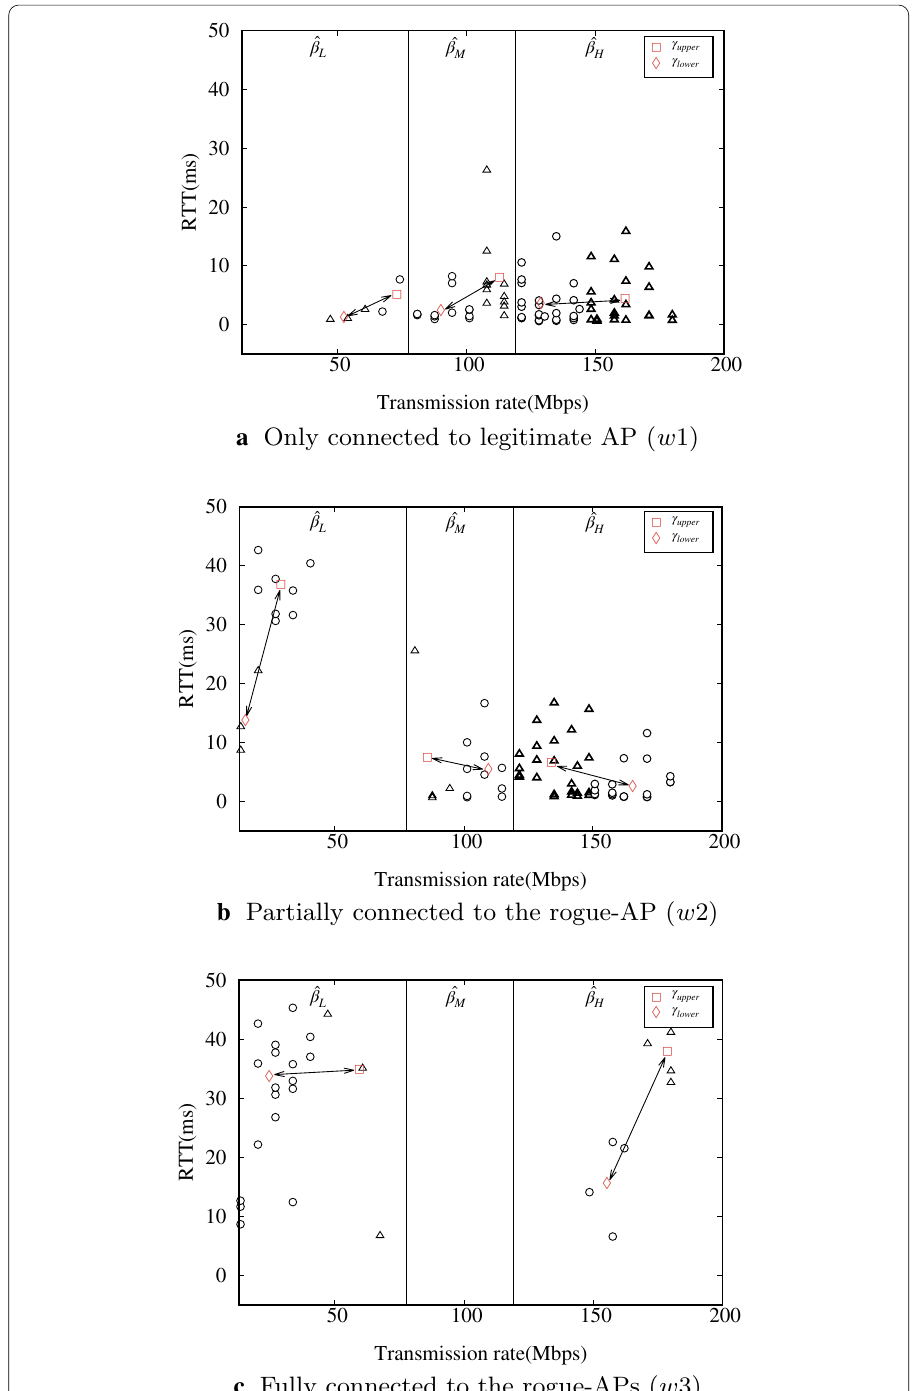
Fig. 14 Distance ratio of two cluster centroids in each data-rate group for selected walking